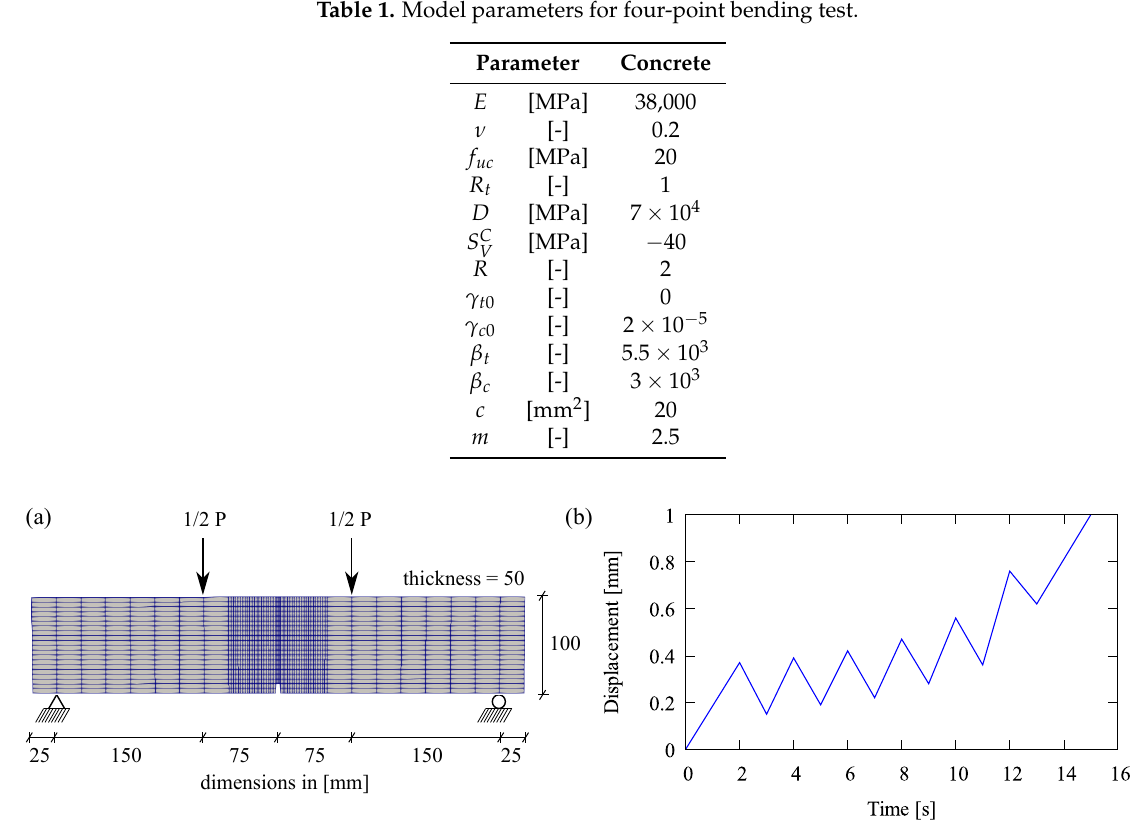
Figure 8. Four-point bending test: ( a ) geometry and ( b ) applied cyclic